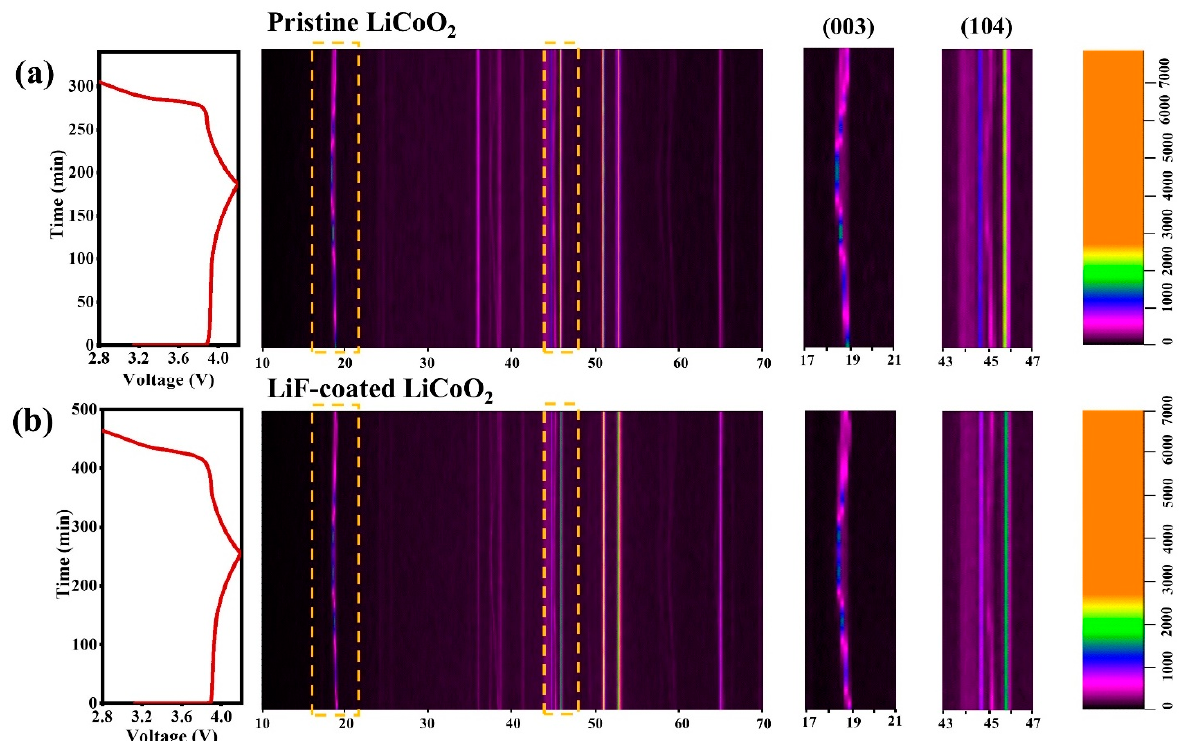
Figure 7. In situ XRD of ( a ) pristine LCO and ( b ) LiF-coated LCO.